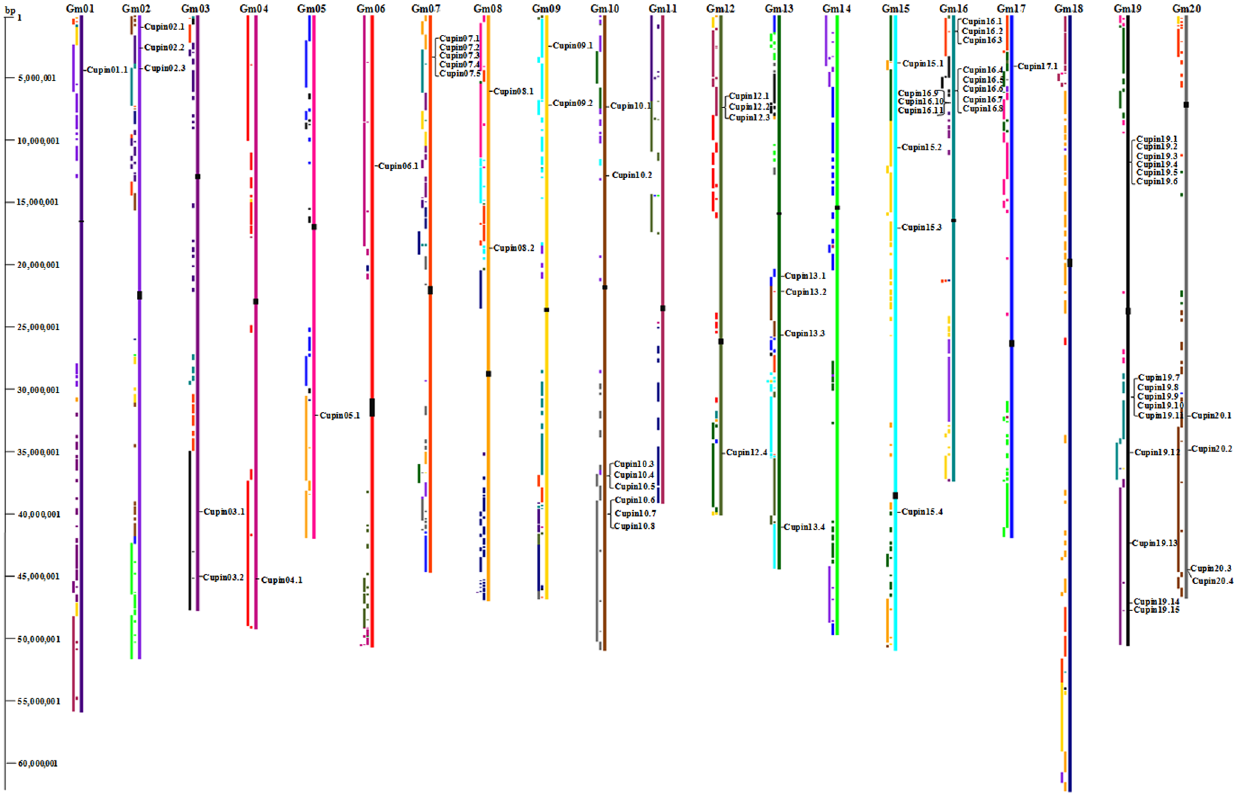
Figure 3. Chromosomal locations and predicted clusters for Gmcupin genes. The schematic diagram of genome-wide chromosome organization and segmental duplication arising from the genome duplication event in soybean was derived from the CViT genome search and synteny viewer at the Legume Information System (http://comparative-legumes.org). The chromosomal positions of all Gmcupin genes were mapped on each chromosome. Colored blocks to the left of each chromosome show duplications with chromosomes of the same color. The chromosome numbers are indicated at the top of each bar and sizes of chromosomes are represented by the vertical scale. The locations of centromeric repeats are shown as black rectangles over the chromosomes.